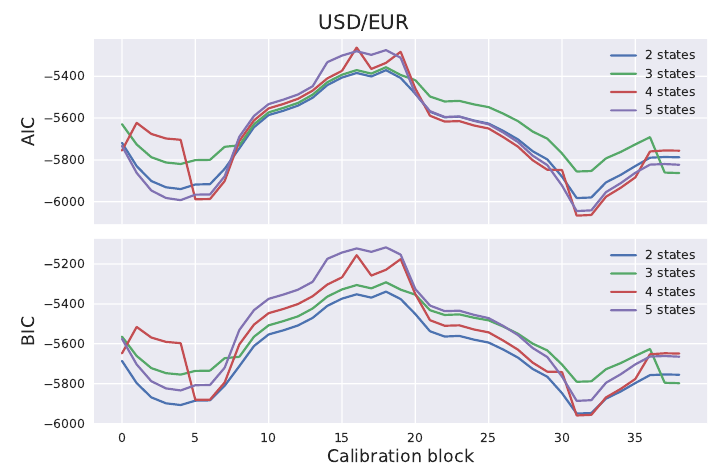
Figure 3. Akaike information criterion (AIC) and Bayesian information criterion (BIC) for HMMs calibrated using USD/EUR time-series.